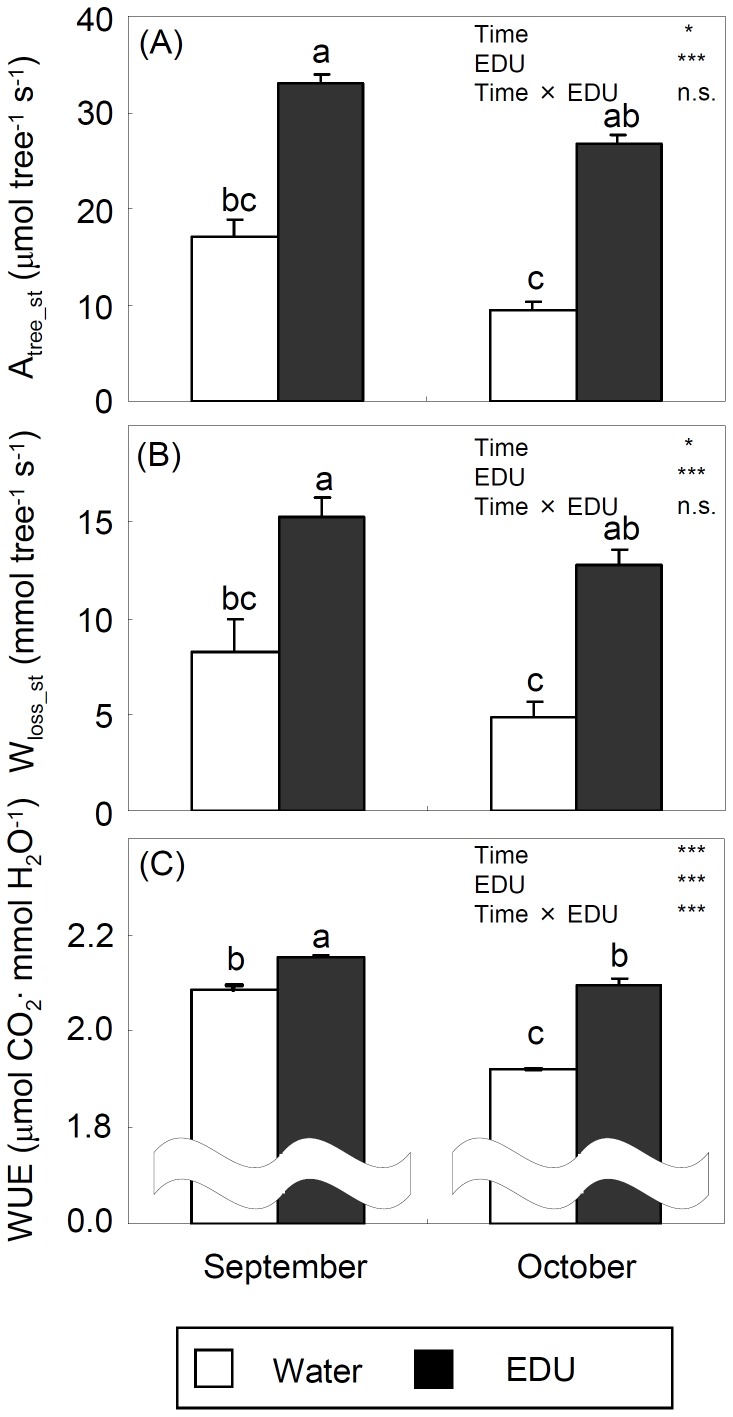
Estimated carbon assimilation (A: Atree_st), water loss (B: Wloss_st) and instantaneous water use efficiency expressed as Atree_st/Wloss_st (C: WUE_st) at tree level under severe water stress imposed by severing a leaf (+SE) (WAT: water treated plants; EDU: EDU treated plants).* and *** denote significance at the 5% and 0.1% level, respectively; n.s. indicates no significance. Different letters above the bars indicate significant differences among bars (Tukey HSD test, P<0.05, n = 5 trees).